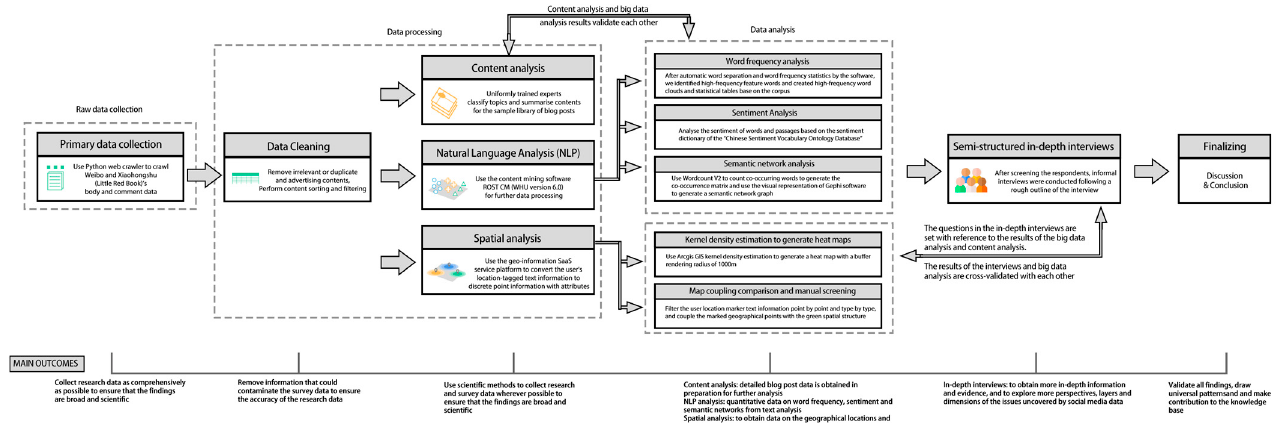
Figure 1. Framework diagram of research ideas.